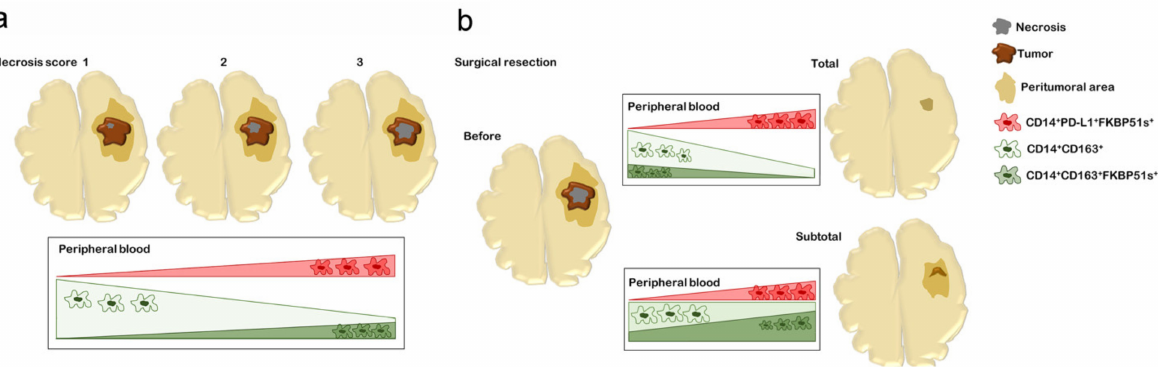
Figure 5. Visual summary of the main findings of the article. The cartoon shows that FKBP51s marked CD163+ monocytes (green) or PD-L1+ monocytes (red) that responded in a different way to tumor necrosis score ( a ) or extent of surgical resection ( b) . ( a ) PD-L1+FKBP51s+ monocytes increased with the tumor necrosis score. By contrast, CD163+ monocytes decreased with the necrosis score. This trend was reversed, albeit not significantly, in CD163+FKBP51s+ monocytes. ( b ) The PD-L1+FKBP51s+ subset had a postoperative increasing tendency, both in the cases of total and subtotal tumor removal. The CD163 + FKBP51s+ monocytes decreased upon total removal, while they increased after subtotal removal.